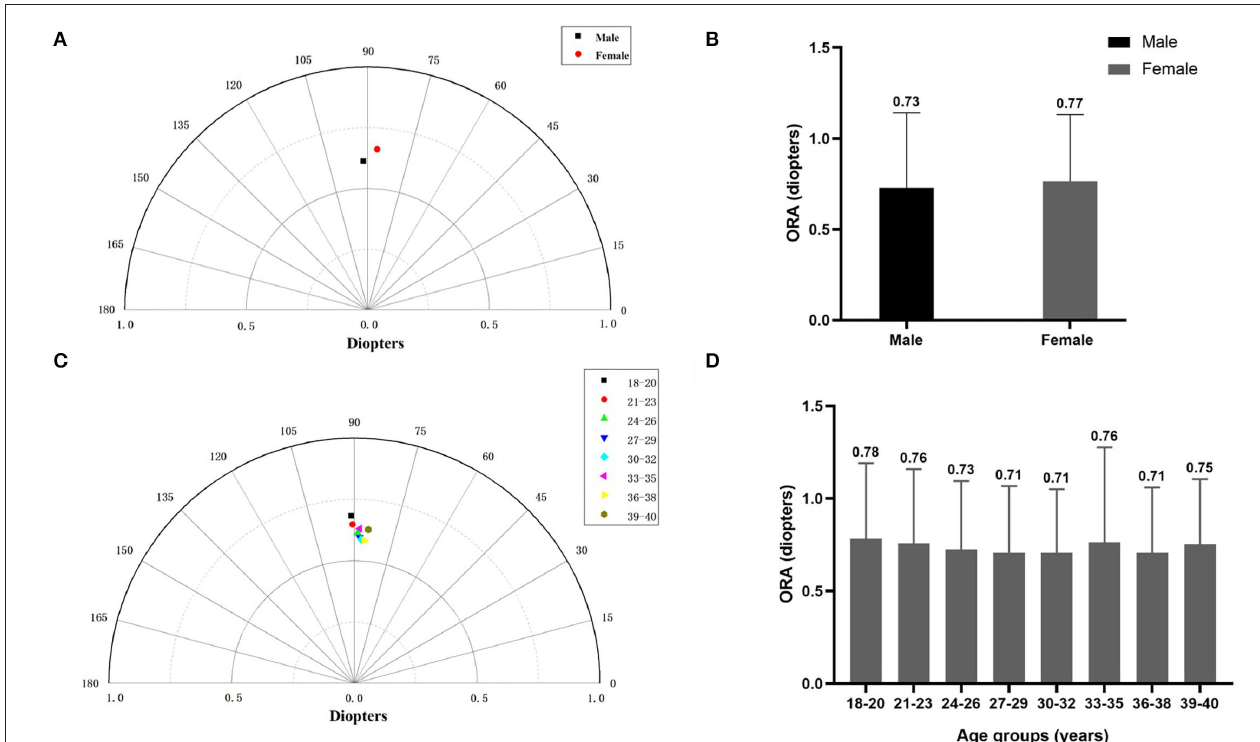
FIGURE 2 | (A) The summated vector mean of ocular residual astigmatism (ORA) in different gender groups. (B) The mean magnitude of ORA in different gender groups. (C) The summated vector mean of ORA in different age groups. (D) The mean magnitude of ORA in different age